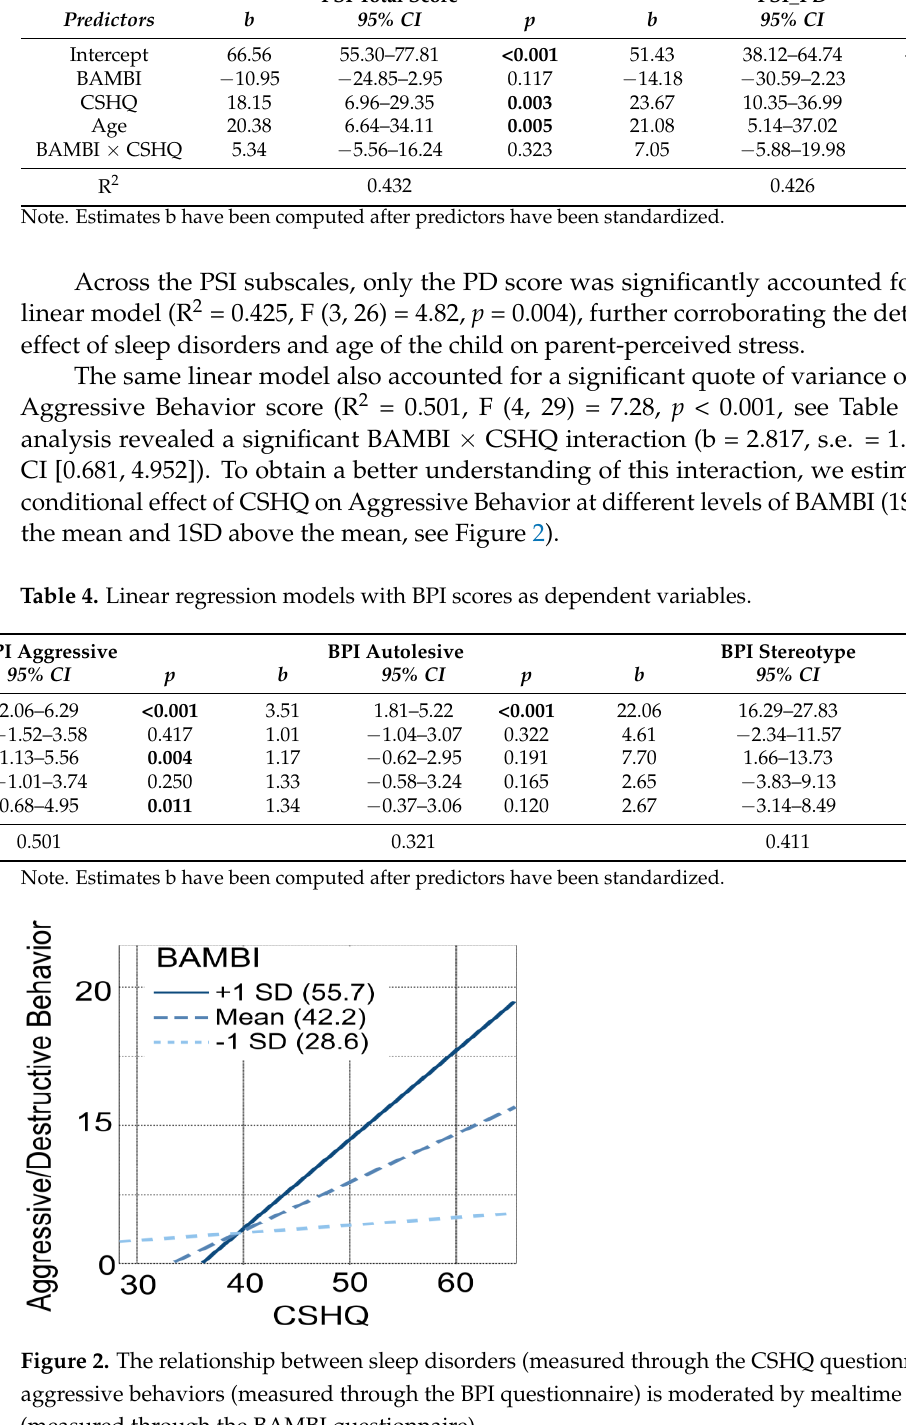
Table 3. Linear regression models with PSI scores as dependent variables.